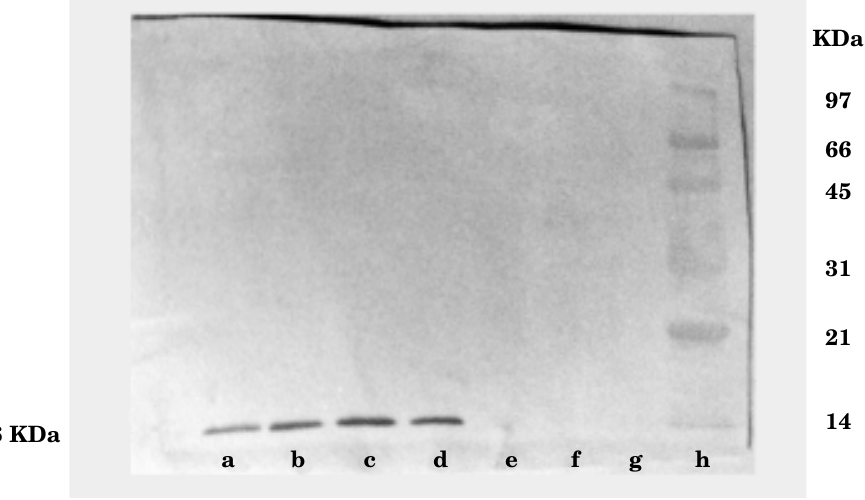
Fig. 2. Immunoblot analysis of proteins extracted from cowpea plants. Acidic PR proteins were extracted from leaves on day 2 after the 2 nd treatment. Proteins were fractionated by SDS-PAGE, and immunoblotted with mouse monoclonal antibody MAb 2-11G5 against tobacco acidic PR-1 protein. lane a, uninoculated and treated with salicyl- ic acid; lane b, uninoculated and treated with salicylic acid containing Tween; lane c, inoculated and treated with salicylic acid containing Tween; lane d, inoculated and treated with salicylic acid; lane e, inoculated and treated with Tween; lane f, inoculated untreated; lane g, uninoculated untreated; lane h, molecular weight